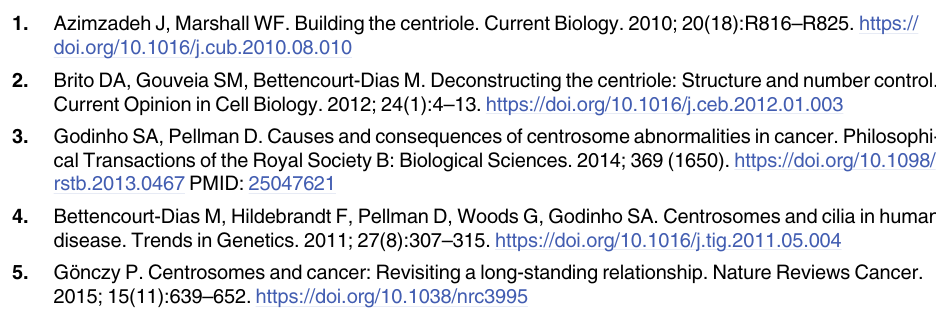
S7 Fig. Parameter estimation is accurate and estimation errors are likely due to small sam- ple sizes. Difference between the median value of the parametric bootstrap distribution for each parameter value and the input value for the simulated data (in black) and difference between the confidence interval length of the non-parametric and parametric bootstrap